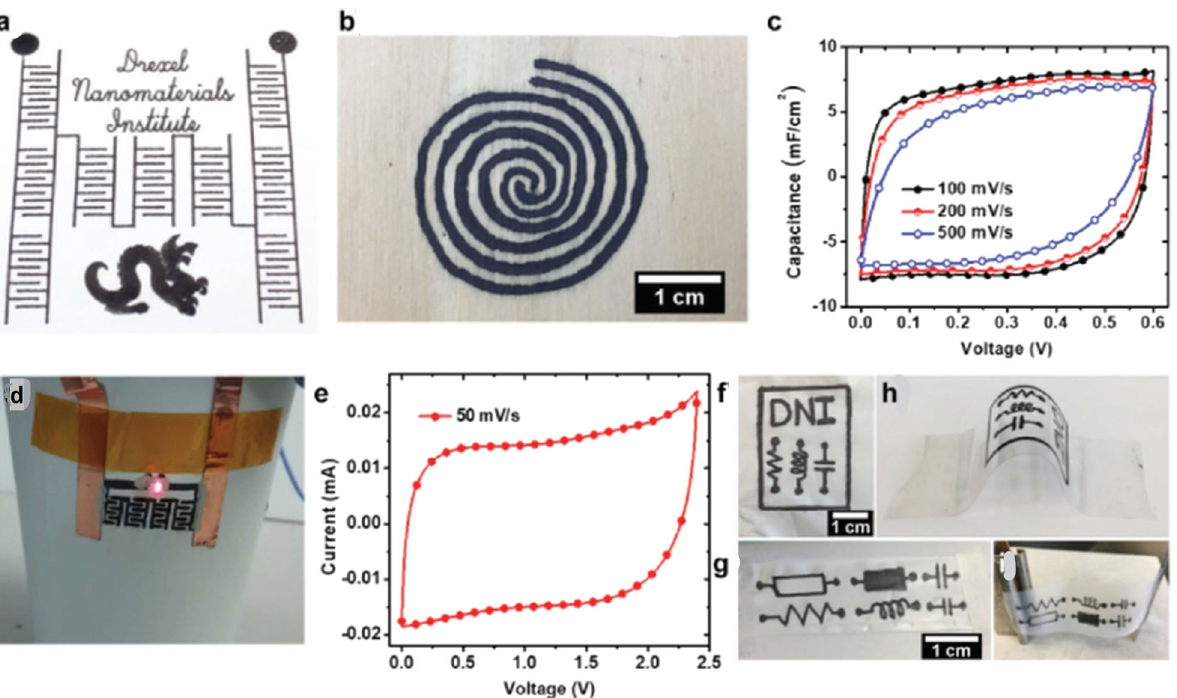
Fig. 9 Micro-supercapacitor fabrication using MXene ink Pen. a An array of micro-supercapacitors of MXene ink written on paper, b optical images of patterned spiral MXene circuit, c cyclic voltammograms (CVs) at different scan rates of MXene-based m-SC on paper, d A series of four MXene-based micro-supercapacitors joined on a rounded paper cup, e corresponding CV, f – i MXene patterns transferred to scotch tape ( h , i ), from Celgard: a polypropylene membrane ( f , g ). Reprinted with permission from 64